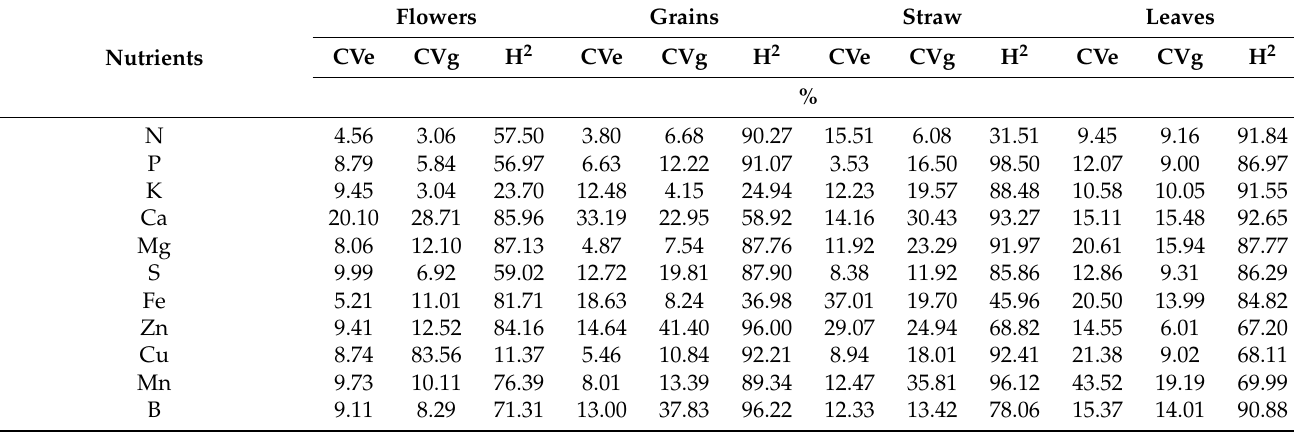
Table 1. Estimates of environmental variation coefficient (CVe), genetic variation coefficient (CVg), and genotypic determi- nation coefficient (H 2 ) for nutrient concentration in flowers, grains, straw, and leaves in nine Coffea canephora genotypes. S ã o Mateus, state of Esp í rito